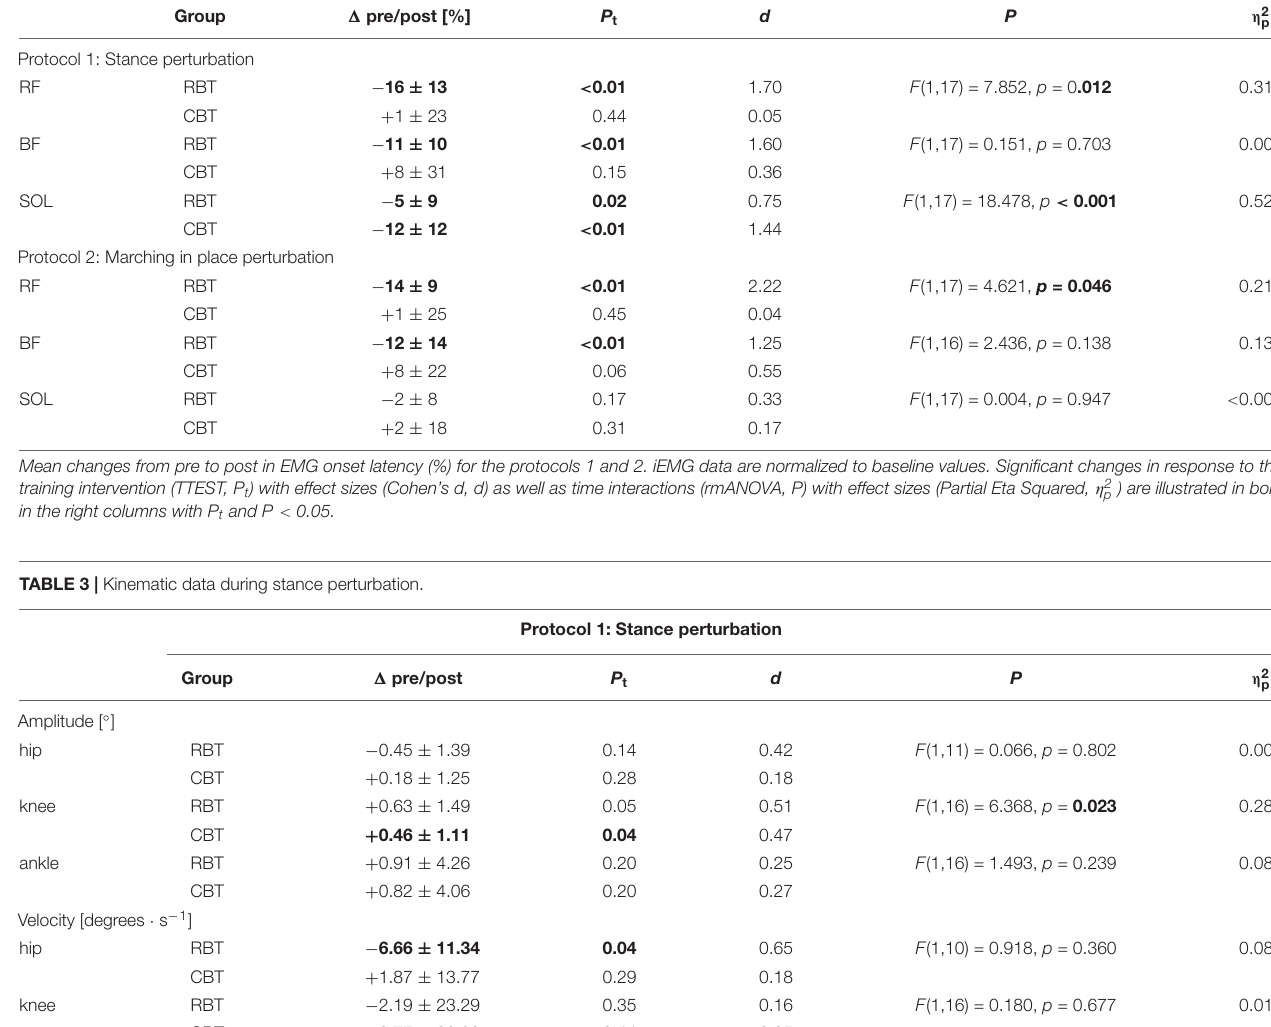
Protocol 1: Stance perturbation